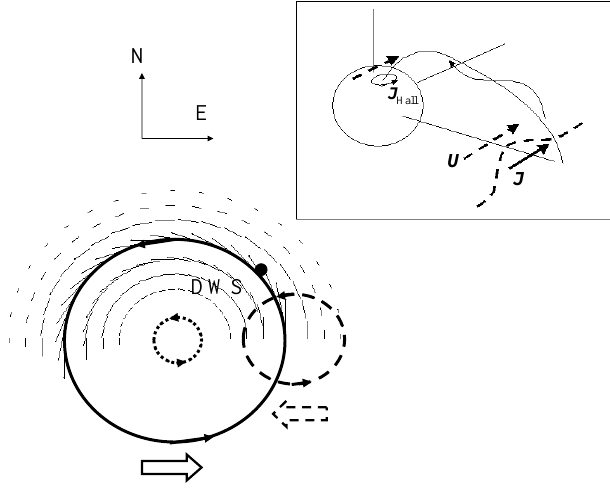
Figure 13. Schematic illustration of the ionospheric loop currents closing counterclockwise. Dotted circles illustrate a loop current growing in intensity. The current loop propagating westward is shown by a dashed circle. The solid circle represents the current loop propagating eastward. The dot indicates the ground magne- tometer station (DWS). The equivalent ionospheric current vectors associated with the loop current shown by the solid line are over- laid. Only the vectors in the poleward half are presented. In the upper-right corner, generation of the ionospheric loop current is il- lustrated by the field line deformations associated with the compres- sional input propagating eastward along the outer boundary at the velocity ( U ) (see text). Displaced surface of the compressional in- put is shown by the dotted curve. The compressional input accom- panied the diamagnetic currents ( J ) flowing eastward. The iono- spheric loop current propagated eastward, following the eastward propagation of the compressional